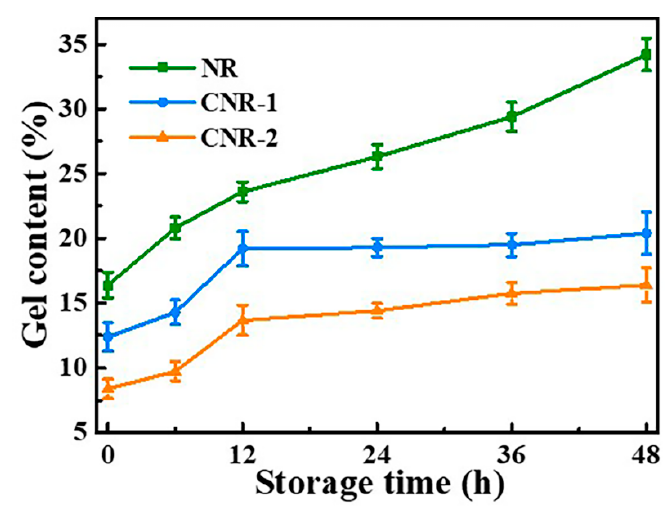
Figure 6. The variation of gel content of NR, CNR-1, and CNR-2 before and after accelerated storage.